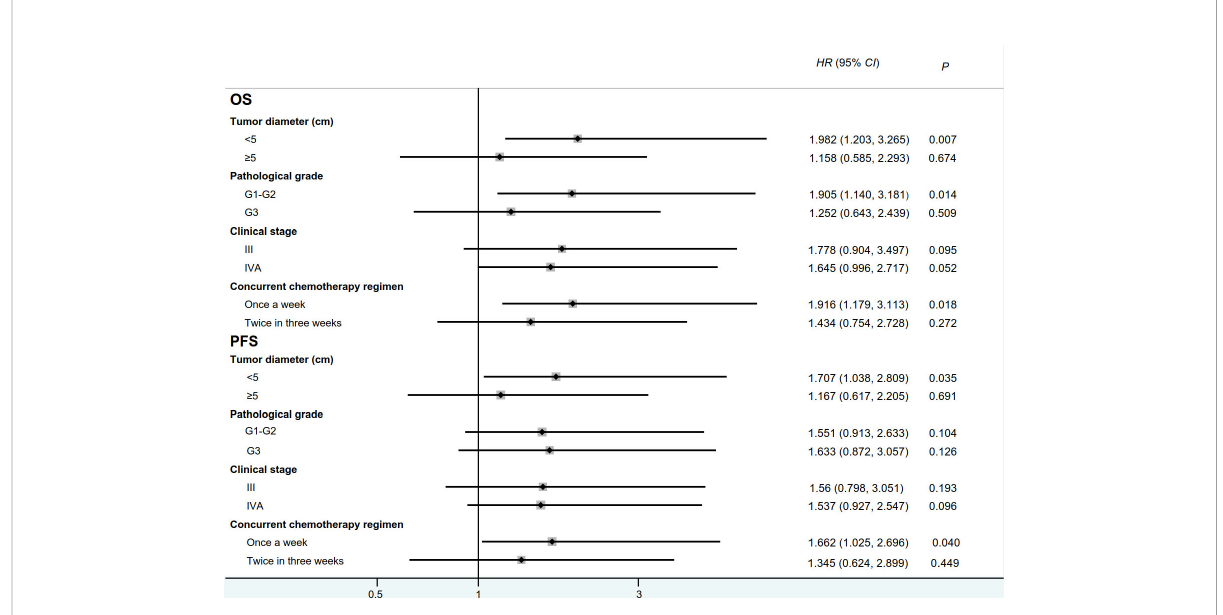
FIGURE 3 Forest plot for overall survival and progression-free survival between IC+CRT group and CRT group. (OS: overall survival, PFS:progression-free survival; HR:hazard